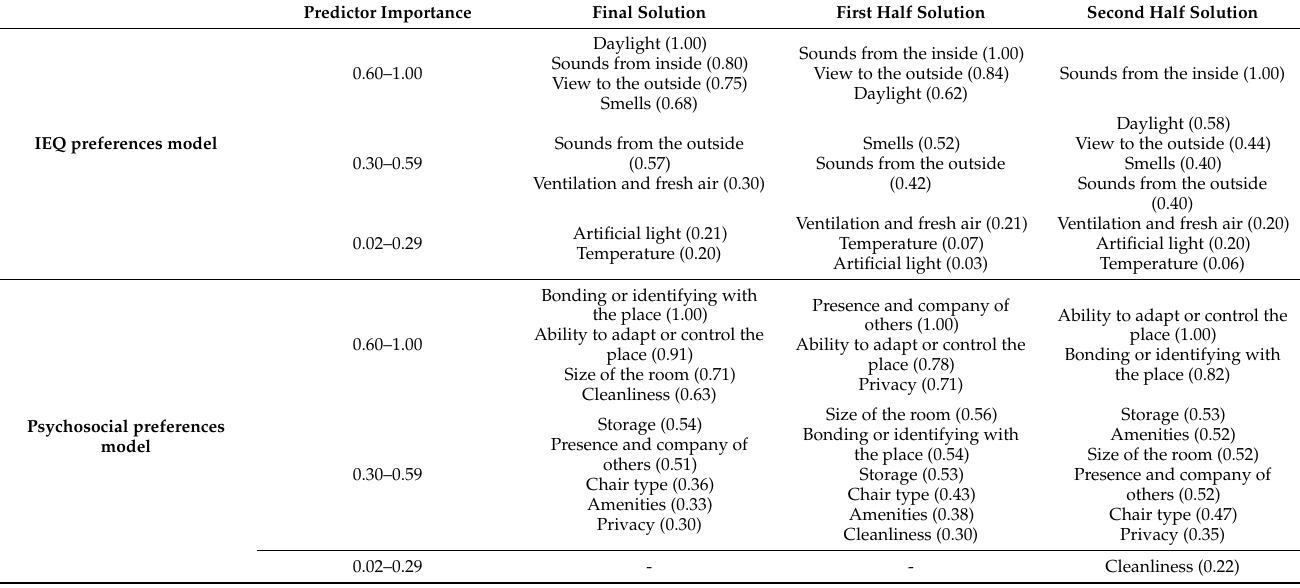
Table 2. Predictor importance of the input variables for both models.